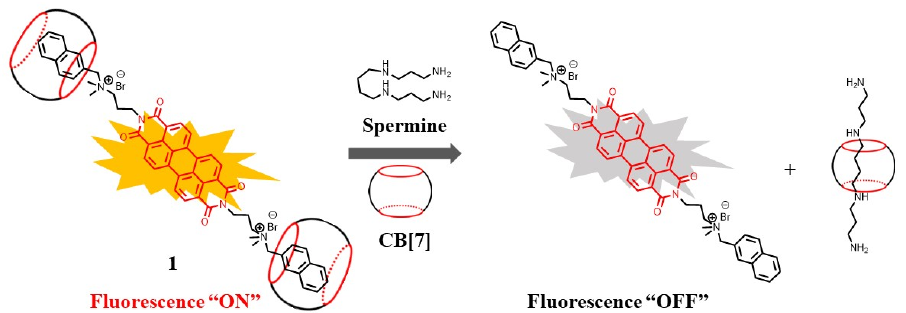
Figure 2. Schematic illustration of the mechanism for sensing spermine, based on supraamphiphiles [44]. phiphiles [44].